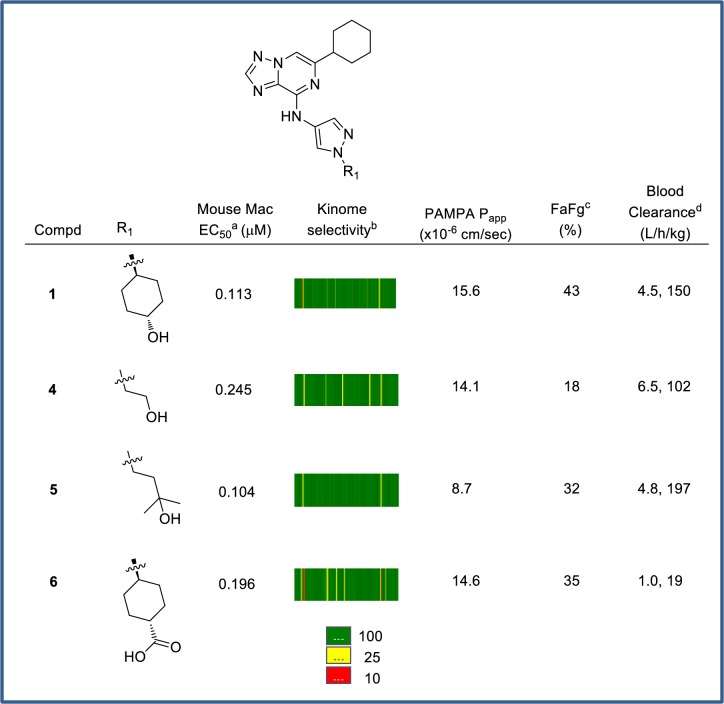
Prodrug candidates.a Mean from n ≥3 experiments. b The kinome selectivity data for a panel of 80 kinases are colored by fold selectivity over CSF1R IC50, with ≤10-fold selective in red and a color gradient to ≥100-fold selective in green. c Mean of 1 (compound 1, 4 and 5) or 3 (compound 6) experiments as described in Materials & Methods. d Mean values determined after a 1 mg/kg IV dose (N = 2–3). Data presented as total clearance and unbound clearance (CLb/fub), respectively.